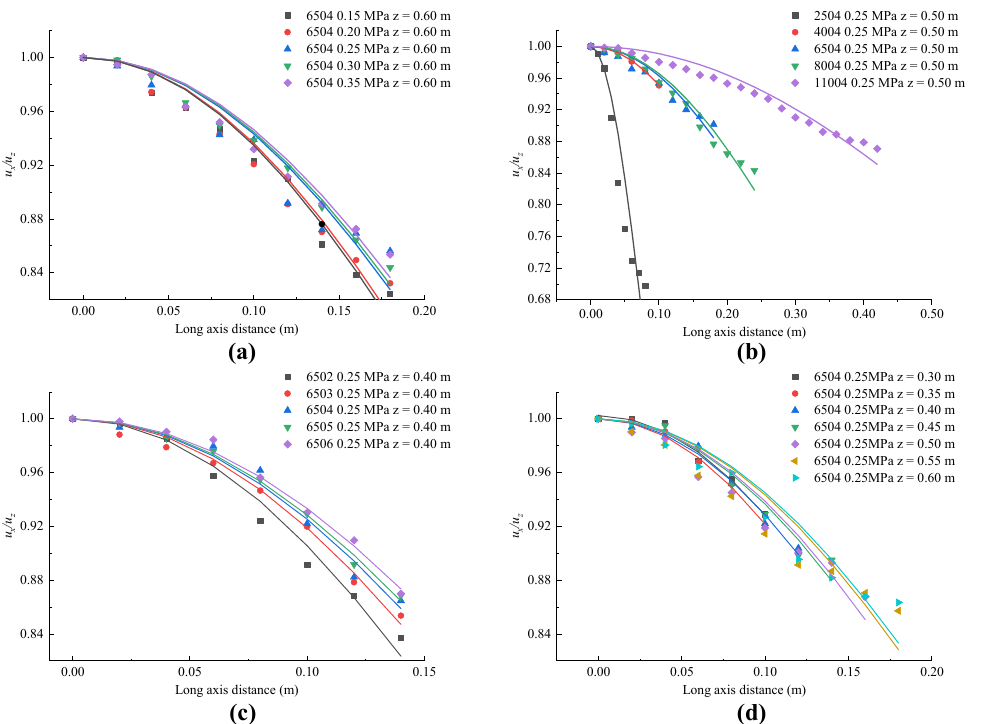
Figure 13. Fitting curves of u x / u z along the X-axis at different spray parameters: ( a ) spray pressure; ( b ) spray angle; ( c ) equivalent orifice diameter; and ( d ) spray distance.